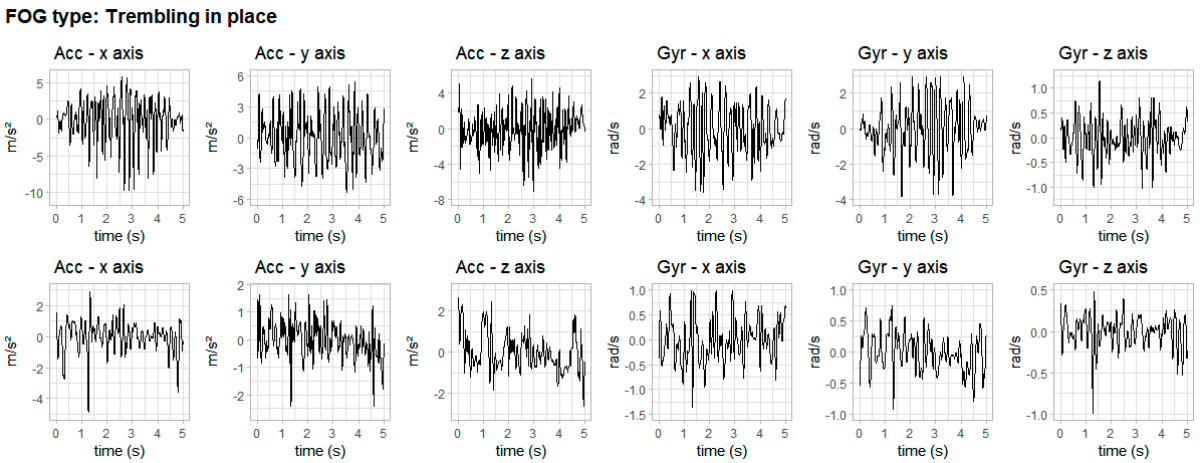
Figure 8. Typical waveforms of inertial signals during trembling in place. Row 1 shows trembling in place in one volunteer and row 2 shows trembling in place in another volunteer.